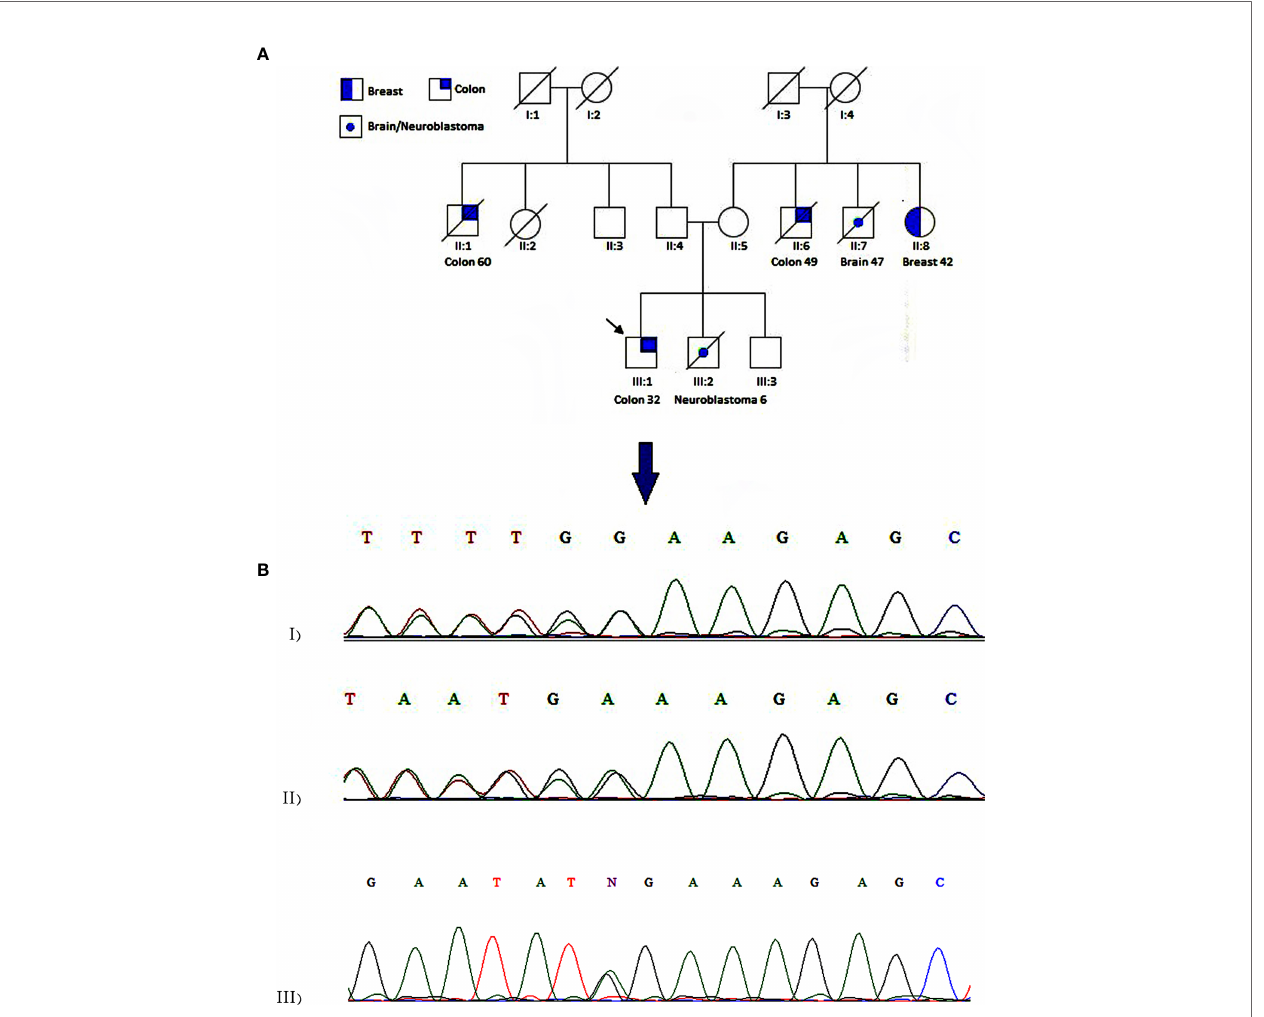
FIGURE 1 | Case presentation (A) Pedigree of the family. The panel shows a family affected with different types of cancer. An arrow designates the studied patient. Colon and breast cancers are indicated by half and quarter fi lled colors, respectively. A central spot demonstrates neuroblastoma or brain cancer. (B) Chromatogram showing heterozygous c.1163delA mutation in WRN gene for proband (I) and patient II:8 (II). A homozygous wild-type variant was detected in the proband ’ s unaffected brother